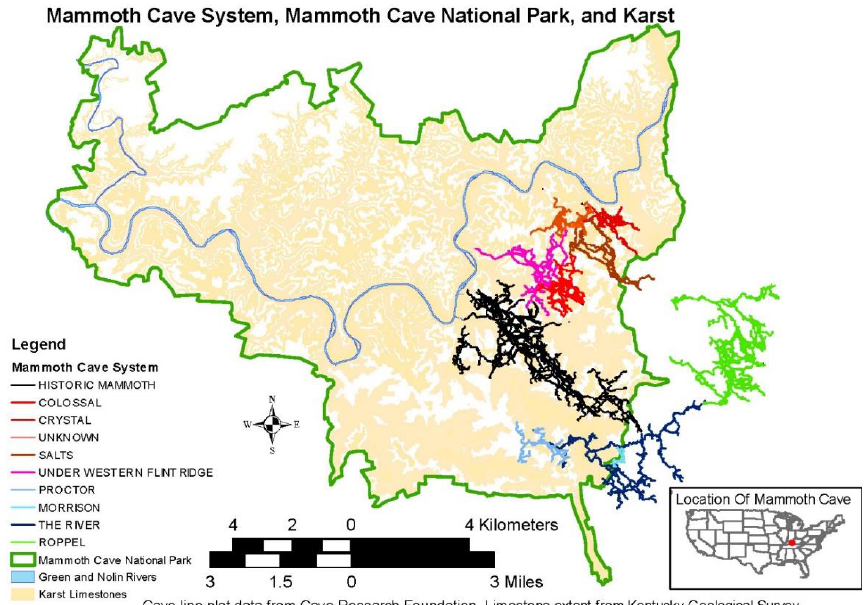
Figure 1. Map showing the location of Mammoth Cave National Park (MCNP) and the extent of the Mammoth Cave System in and adjacent to MCNP. The major segments of the Mammoth Cave Sys- tem are shown as line plots in various colors. The different segments explored from different entrances (27 total). Line plot data from Cave Research Foundation. MCNP also contains over 500 smaller caves developed in various karstified limestones that are not attached to the Mammoth Cave System. These are grouped on the map, but include the St. Louis, Ste. Genevieve, Haney, Glen Dean and Girkin Formations. These smaller caves contain a variety of habitats from epikarst to base-level streams.